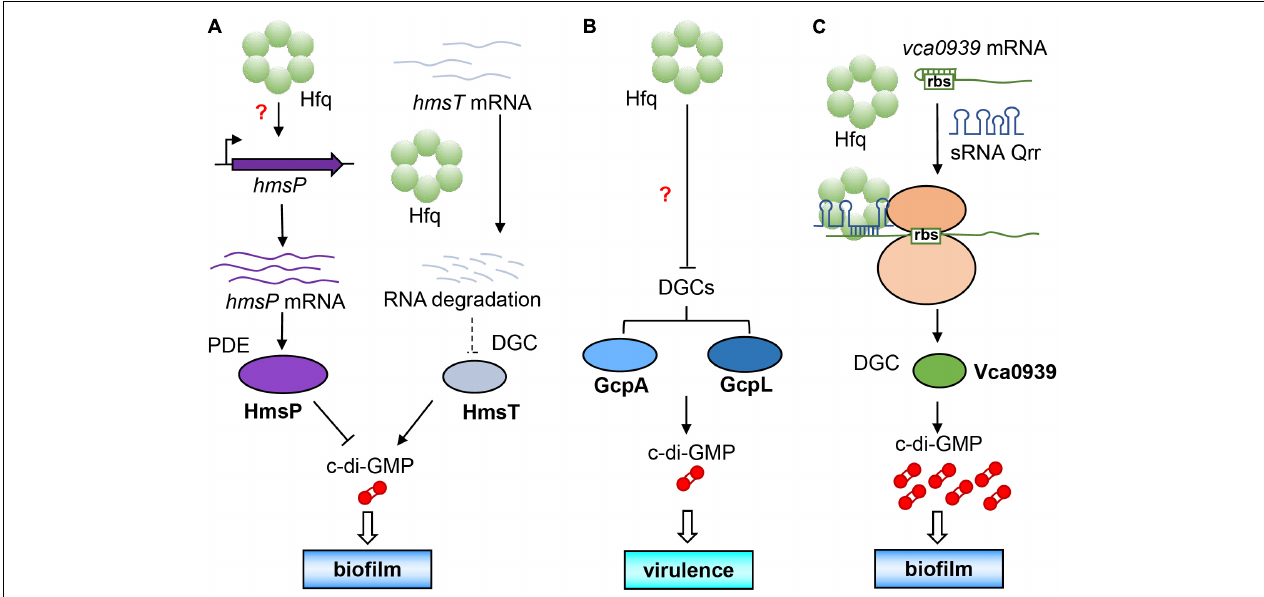
FIGURE 3 | Direct regulation of intracellular c-di-GMP concentration by Hfq. (A) Hfq increases the expression of hmsP PDE gene at the transcriptional level by an unknown mechanism and reduce the expression of HmsT DGC at the post-transcriptional level, causing a decline of c-di-GMP level to affect its biofilm formation. (B) Hfq simultaneously inhibits the expression of two DGCs (GcpA and GcpL) by an unknown mechanism to decrease c-di-GMP biosynthesis, leading to a decreased virulence. (C) With the assistance of Hfq, sRNA Qrr can base pair with the leader sequence of the DGC gene vca0939 mRNA to expose the ribosome binding site for increasing Vca0939 production, leading to increasing c-di-GMP level and biofilm